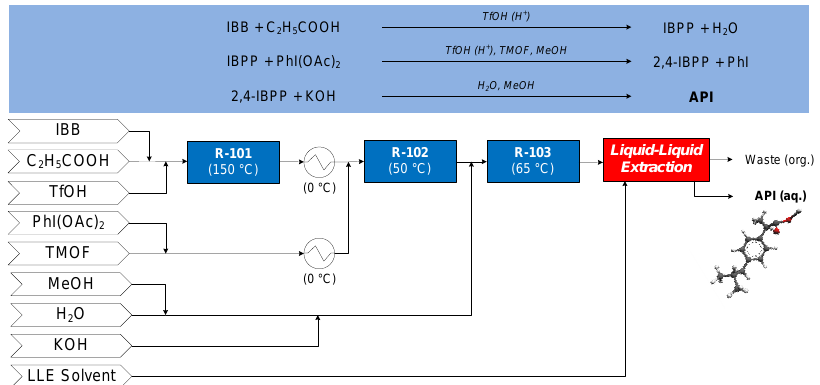
Figure 11. Continuous Pharmaceutical Manufacturing (CPM) flowsheet for ibuprofen: flow synthesis [62] + continuous Liquid–Liquid Extraction LLE [63]. Reproduced with permission from Jolli ff e and Gerogiorgis, Computers and Chemical Engineering; published by Elsevier,